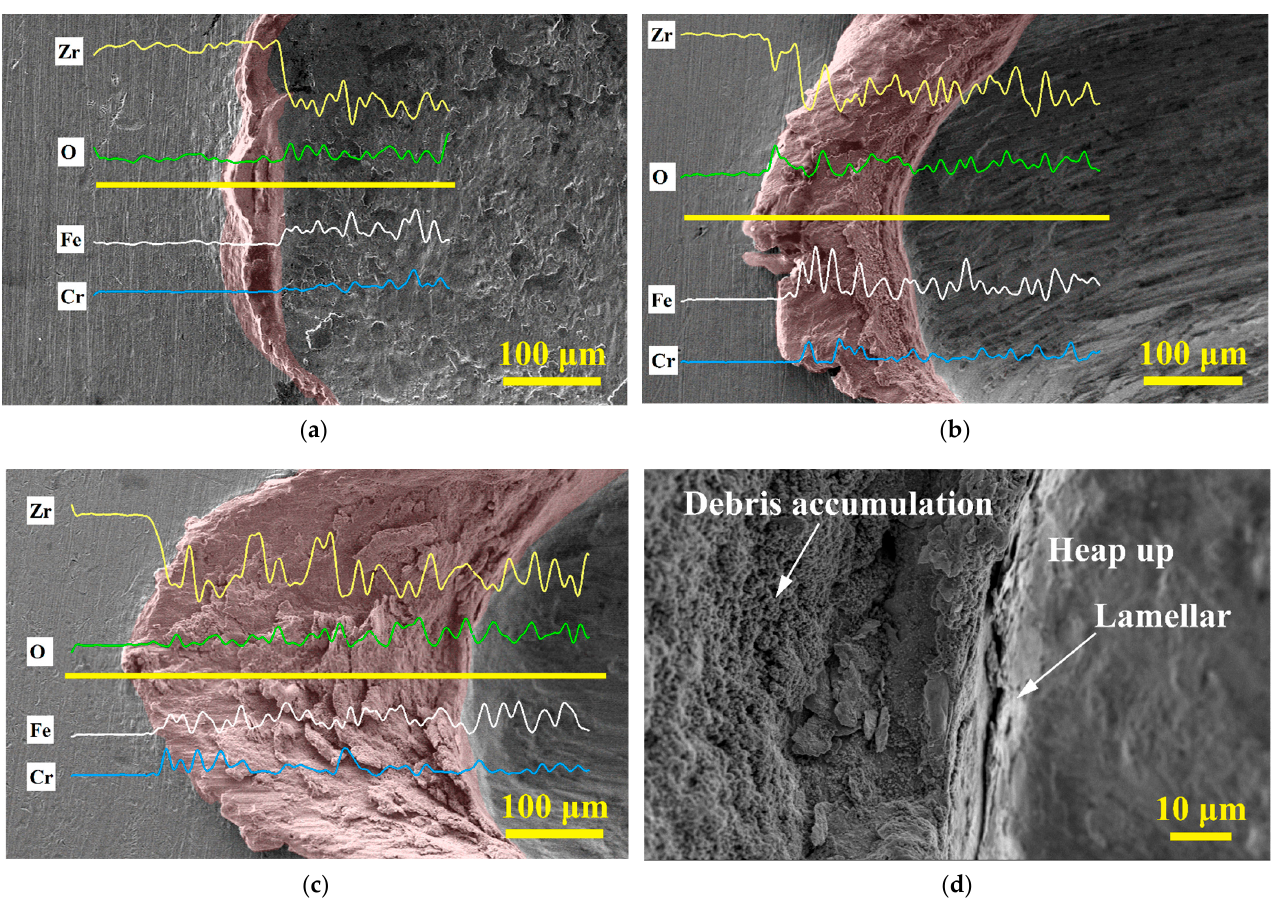
Figure 12. Material accumulation on the left side under different impact angles. ( a ) θ = 90°; ( b ) θ = 60°; ( c ) θ = 45°; and ( d ) wear debris accumulation.